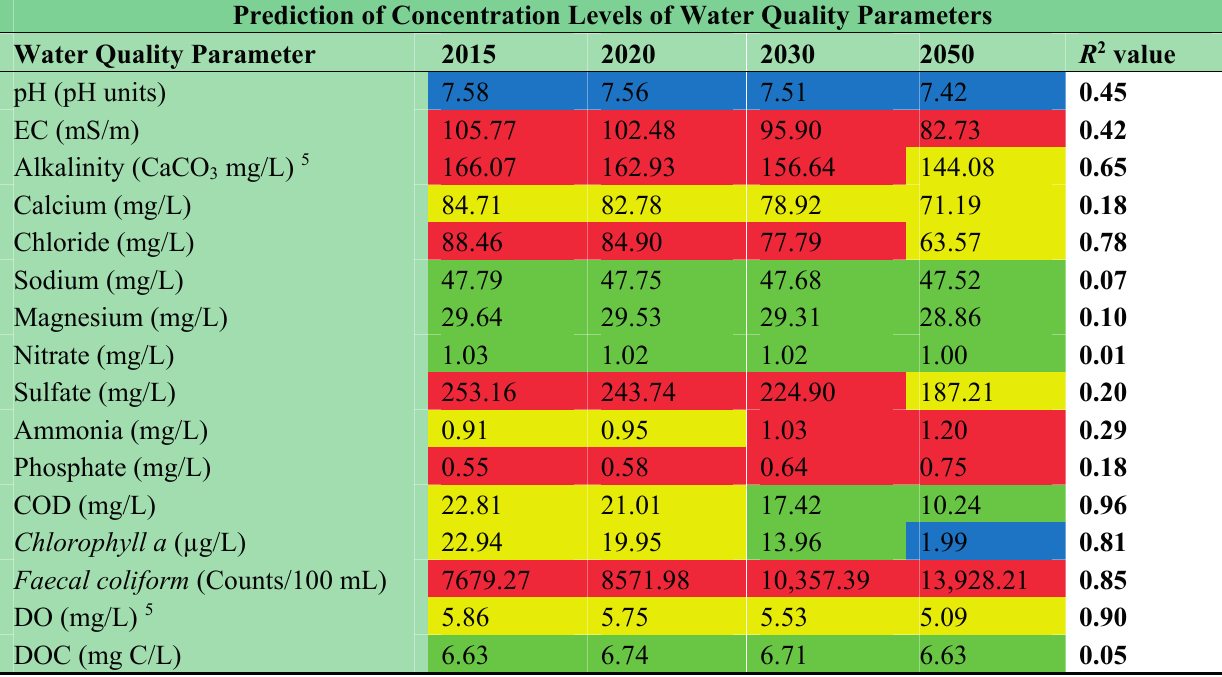
Table 6. Predictions of water quality parameter concentration levels in the event of a 0.5% per year increase in the extent of urban build-up land cover within the Blesbok Spruit catchment showing water quality color classification indicators in terms of the Vaal River Barrage in-stream water quality